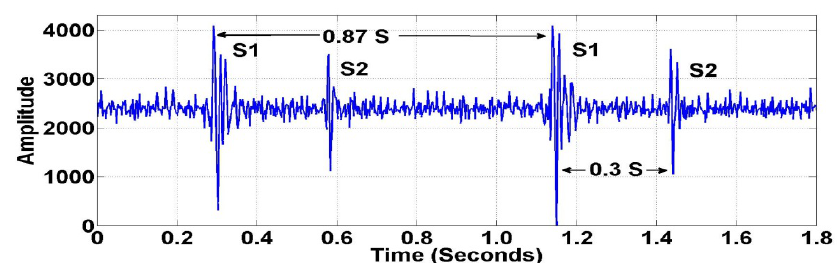
Figure 8. Location, Time Interval of Fundamental Heart Sounds (S1 and S2).